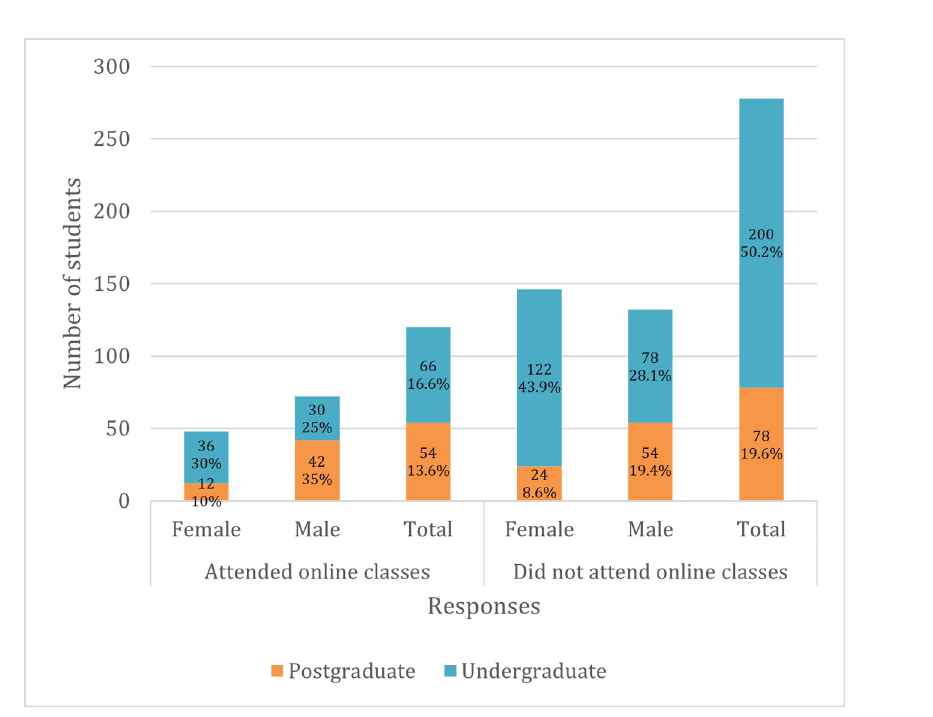
Fig 5. Students’ access to online